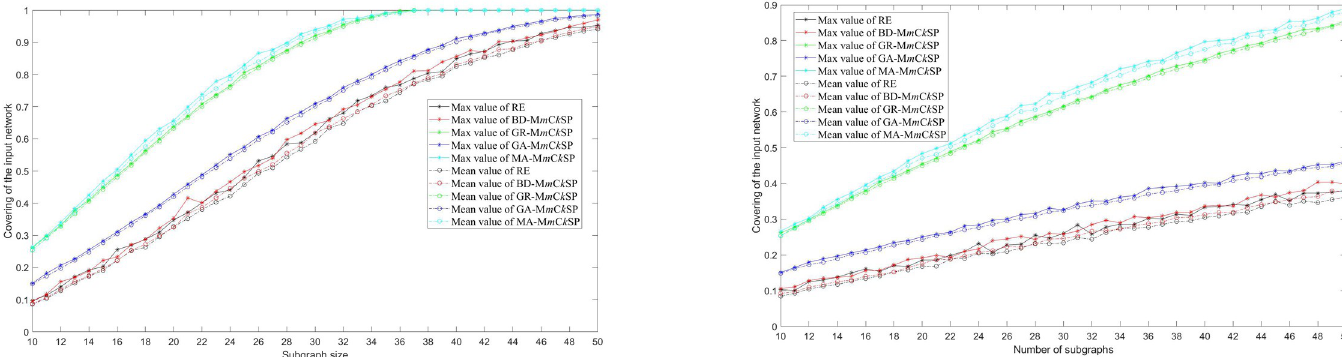
Fig 8. Covering the input random network with RE, BD-M m C k SP, GR-M m C k SP,GA-M m C k SPand MA-M m C k SP. (a) shows the result for different subgraph sizes given the number of subgraphs m = 10; (b) shows the result for different numbers of subgraphs given the subgraph size k = 10. The solid line with stars represents the maximum value of the ten-runs experiment, while the dashed-dotted line with the circles represents the mean value.